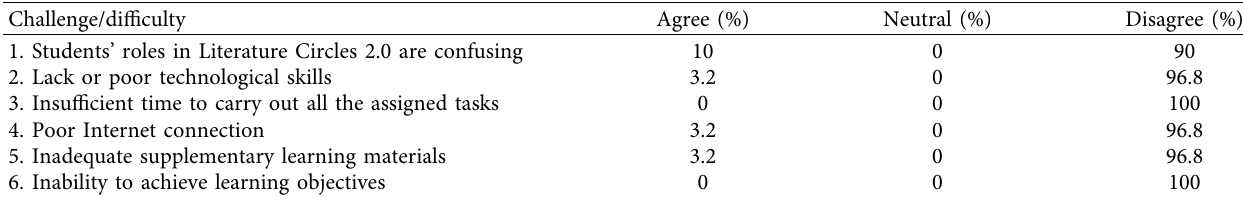
Table 2: Students’ responses to the difficulties encountered in applying Literature Circles 2.0.